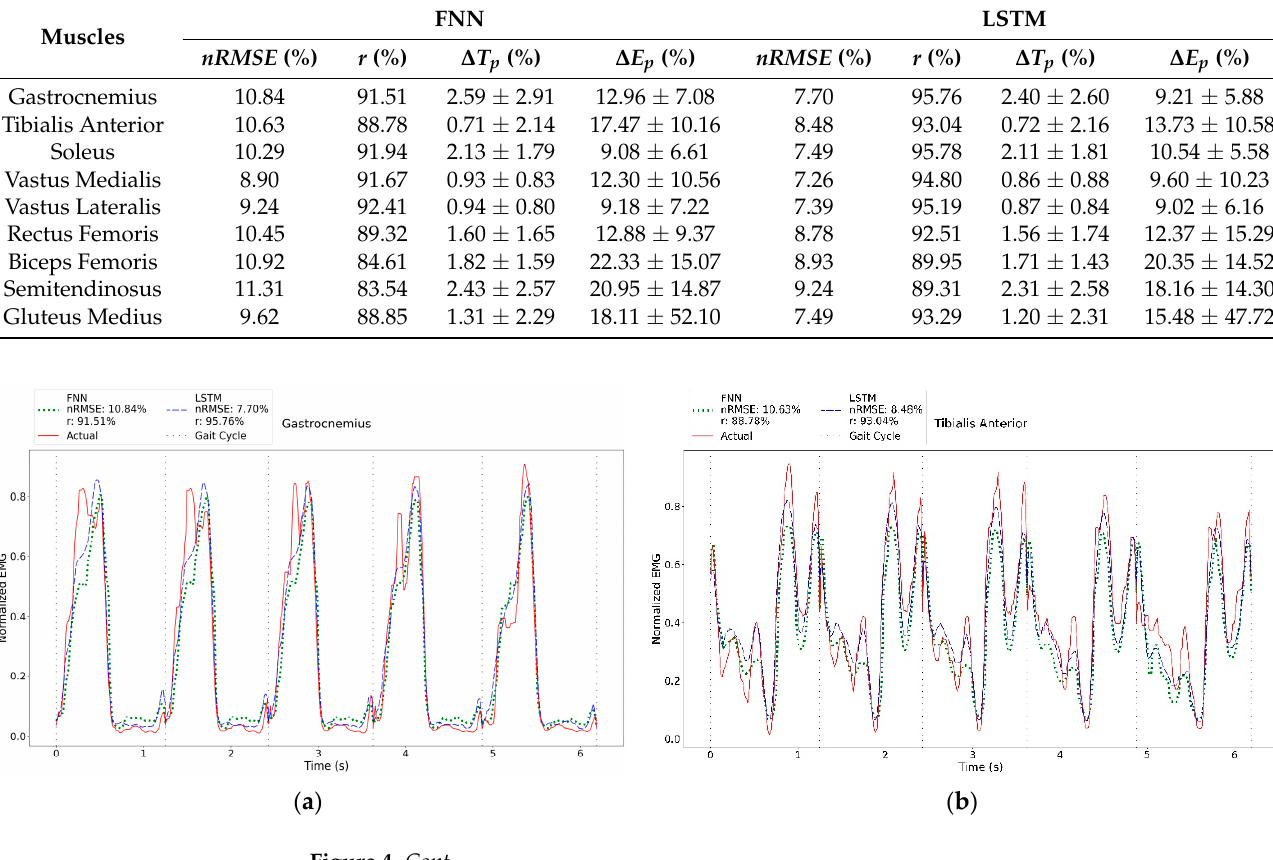
Table 2. Comparison between actual and predicted muscle activities on test data.